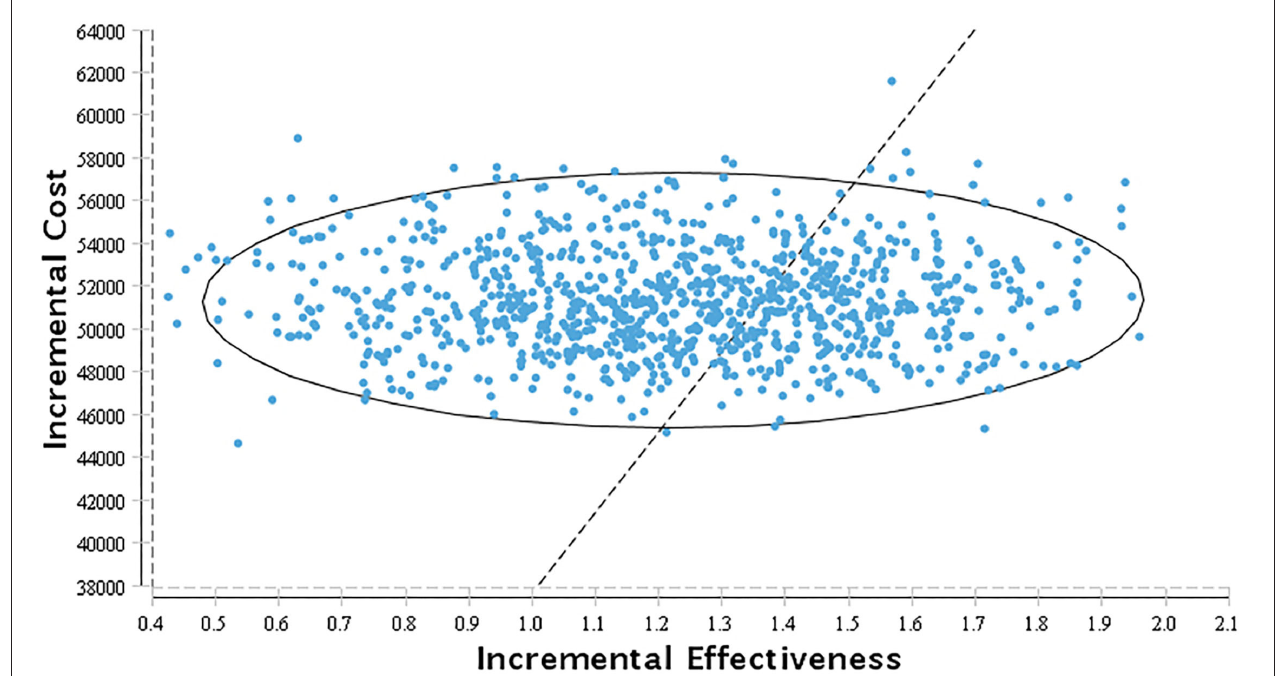
FIGURE 5 | Scatter plot. A probabilistic scatter plot of the ICER between the pembrolizumab and chemotherapy group. Each dot represents the ICER for 1 simulation.